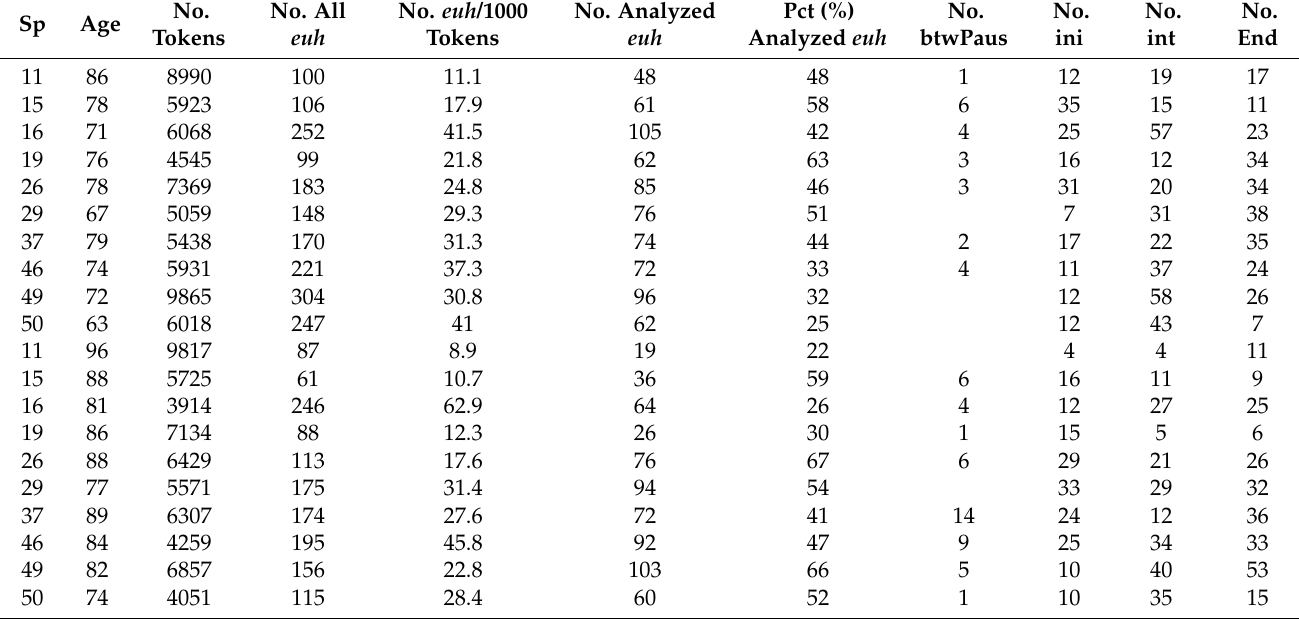
Table A1. The data on total euh quantity per speaker (columns 3–5) were drawn from the LangAge corpus. Columns 6–11 show the data analyzed here, including the breakdown across positional contexts. Since the between-Pause context was small and not balanced across speakers, the number of analyzed euh includes the other three contexts (ini, init, end) only. The data show extensive speaker differences in euh usage which can be explored in future